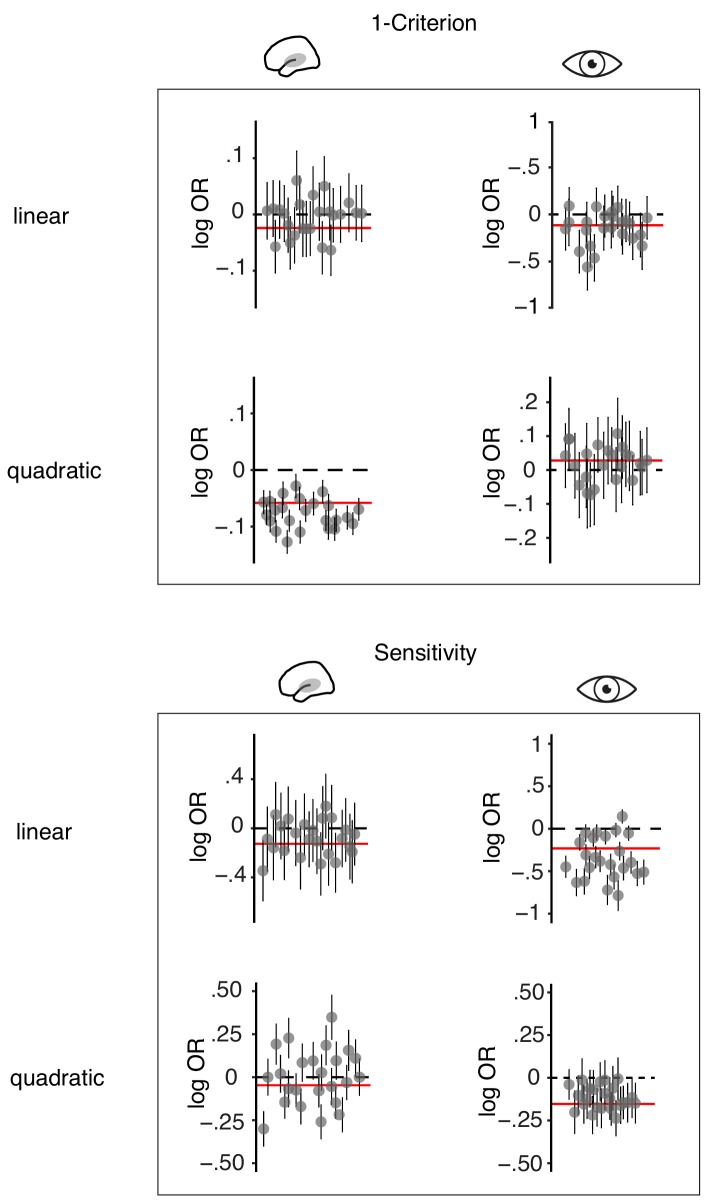
Overview of fixed and random effects.